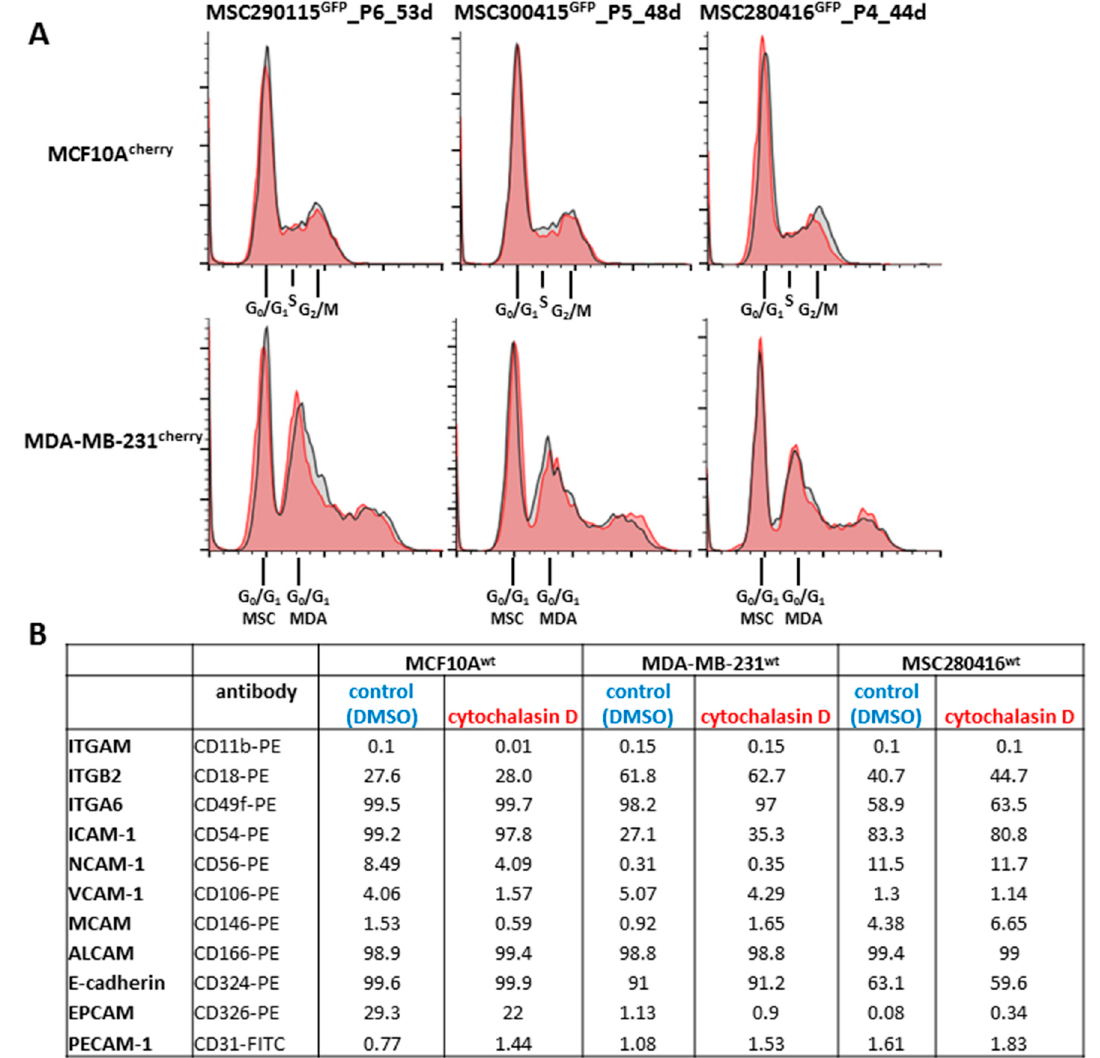
Figure 2. Cell cycle analysis and surface marker expression during cytochalasin D stimulation. ( A ) Cell cycle analysis of the indicated co-cultures was performed by DNA labeling with propidium-iodide and analyzed via flow cytometry. The grey histograms represent control co-cultures in solvent dilution (DMSO), and the red histograms demonstrate exposure to 0.05 µ M cytochalasin D in DMSO for 24 h. ( B ) Cell surface marker expression analysis of different cell adhesion molecules in MCF10A wt , MDA-MB-231 wt , and MSC280416 wt cell populations was examined by flow cytometry, and the percentage of appropriate expression is documented in control cells after the appropriate solvent dilution (DMSO), as compared to treatment with 0.05 µ M cytochalasin D in DMSO for 24 h, respectively.